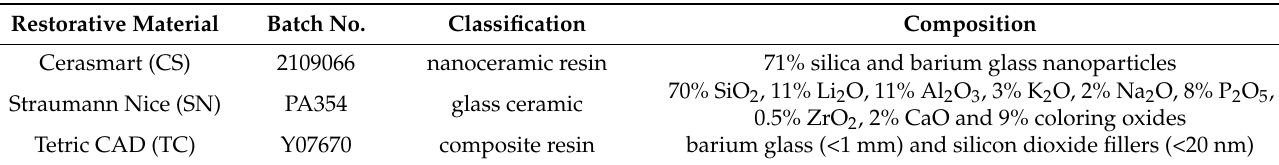
Table 1. Batch number, classification, and composition of the restorative materials used. Restorative Material